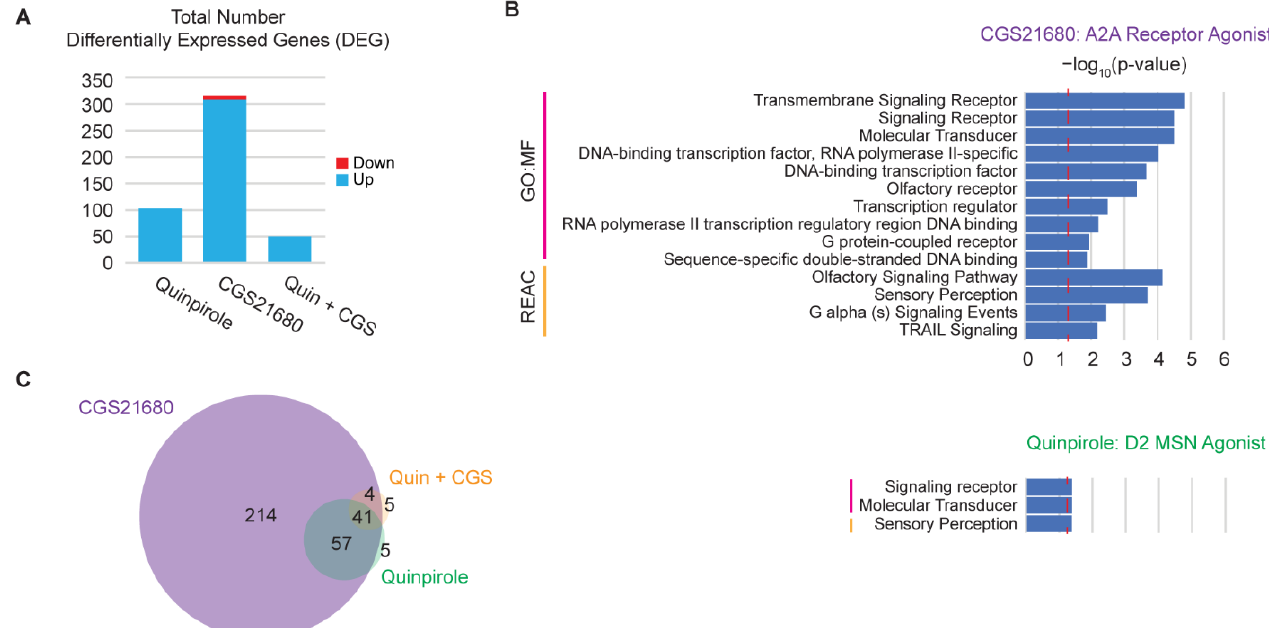
Figure 5. hMSN-like cells capture some features of dopamine receptor cross-interactions. ( A ) Total number of DEGs from RNA-seq of DIV45 hMSN-like cells dosed with receptor agonists. ( B ) Gene ontology molecular functions and reactome pathways for DEGs from hMSN-like cells dosed with ADORA2A agonist CGS21680 and D2-like receptor agonist quinpirole. Dotted red line indicates p -value of 0.05. ( C ) Venn diagram showing shared and unique numbers of DEGs for DIV45 hMSN-like cells dosed with agonists. In all cases, data were obtained from RNA-seq of DIV45 H9 hMSN-like cells. DEGs were identified by FDR p -value < 0.05. Differential expression was performed against a water (vehicle) control group using the Wald test. n = 3 independent